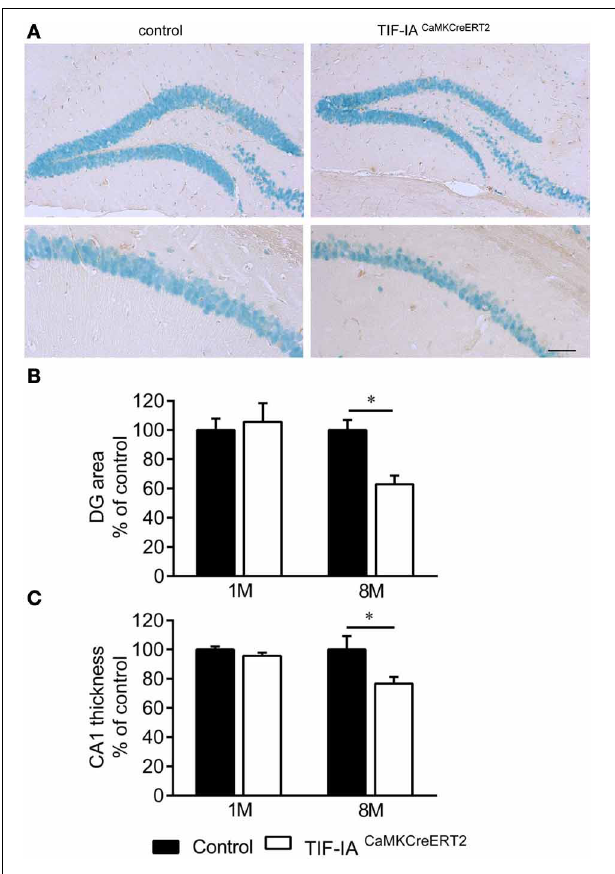
FIGURE 2 | Hippocampal neurons survive in DG and CA1 of TIF-IA CaMKCreERT2 mutants. (A) Representative images of IHC with NeuN specific antibody in DG and CA1 of control and TIF-IA CaMKCreERT2 mutant mice 8 months after tamoxifen. (B) Quantification of DG area per section (% of control) in control and TIF-IA CaMKCreERT2 mutant mice 1 and 8 months after tamoxifen. (C) Quantification of CA1 thickness (% of control) in control and TIF-IA CaMKCreERT2 mutant mice 1 and 8 months after tamoxifen; n = 5. Error bars represent SEM. Scale bar: 120 μ m. ∗ p < 0 . 05.